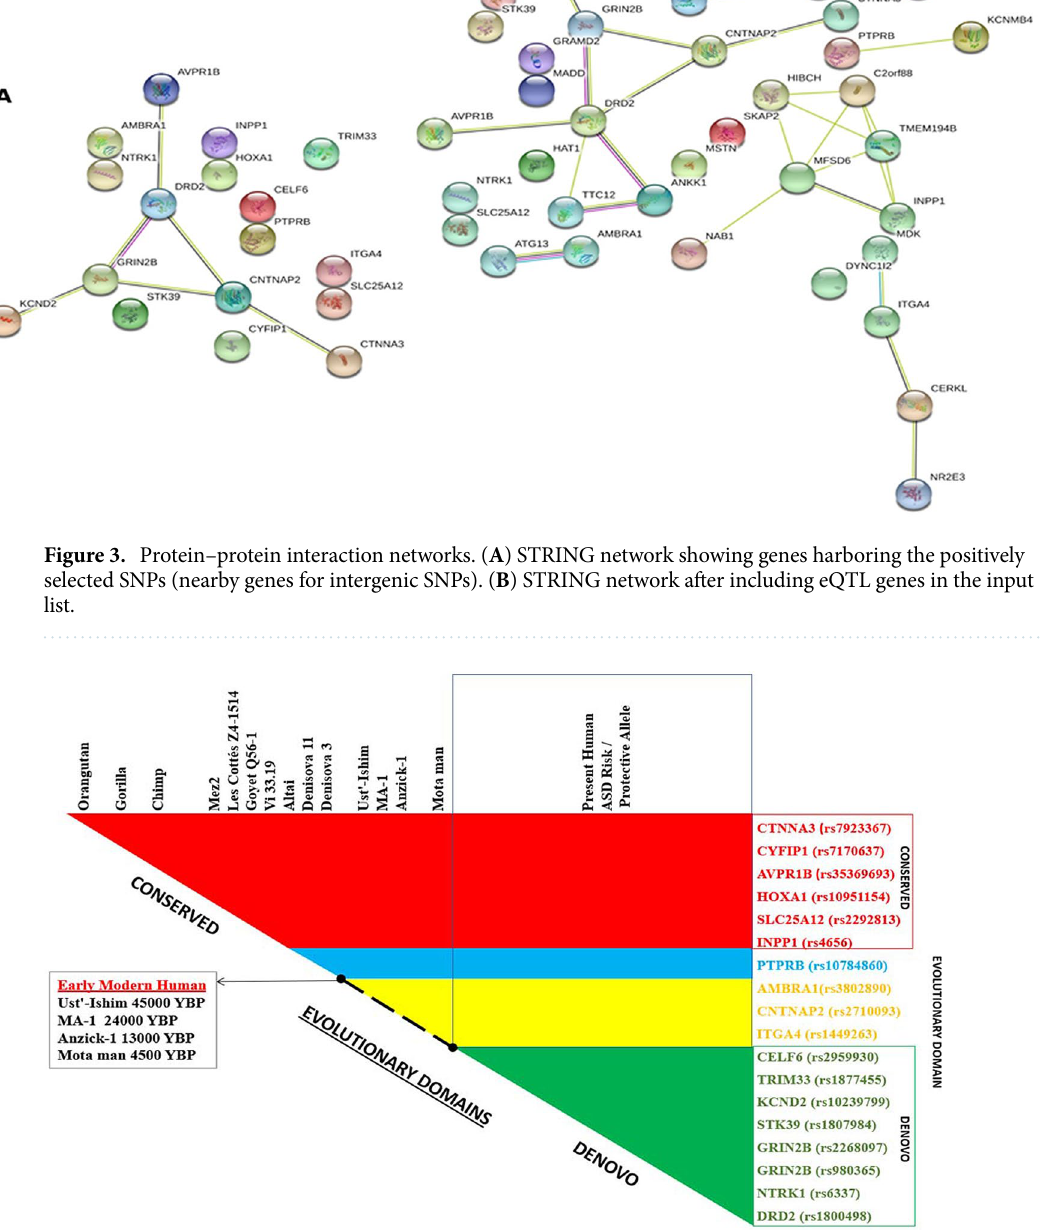
Figure 4. Evolutionary pattern of positively selected ASD risk loci, showing conserved evolutionary selection domain (Red), Denovo evolutionary selection domain (Green), Intermediate selection domain (early to recent Modern